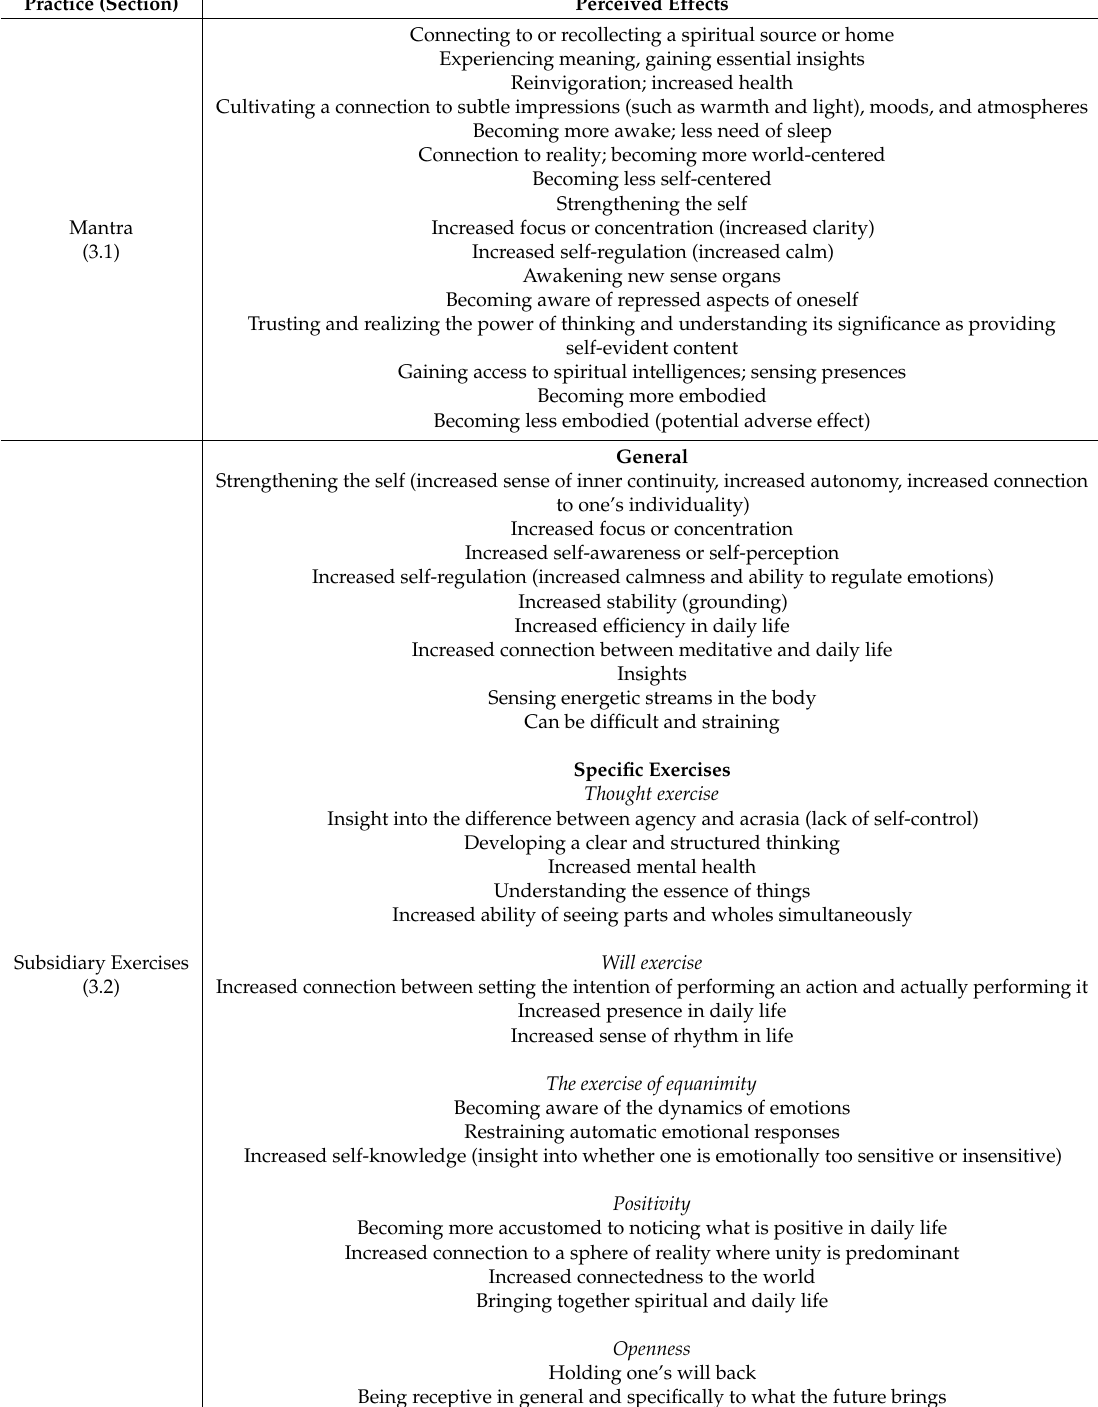
Table 2. Perceived effects of Anthroposophic mantra practice and the subsidiary exercises. Practice